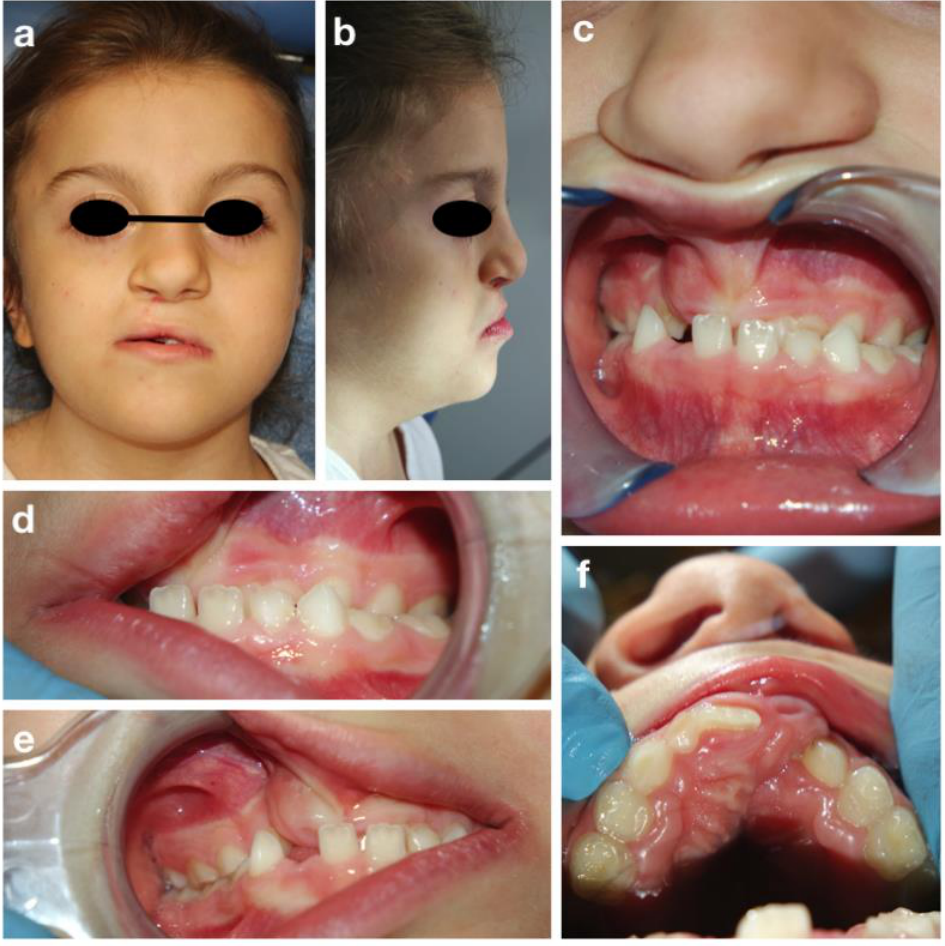
Figure 4. CHARGE syndrome: extra-oral ( a , b ) and intra-oral pictures ( c – f